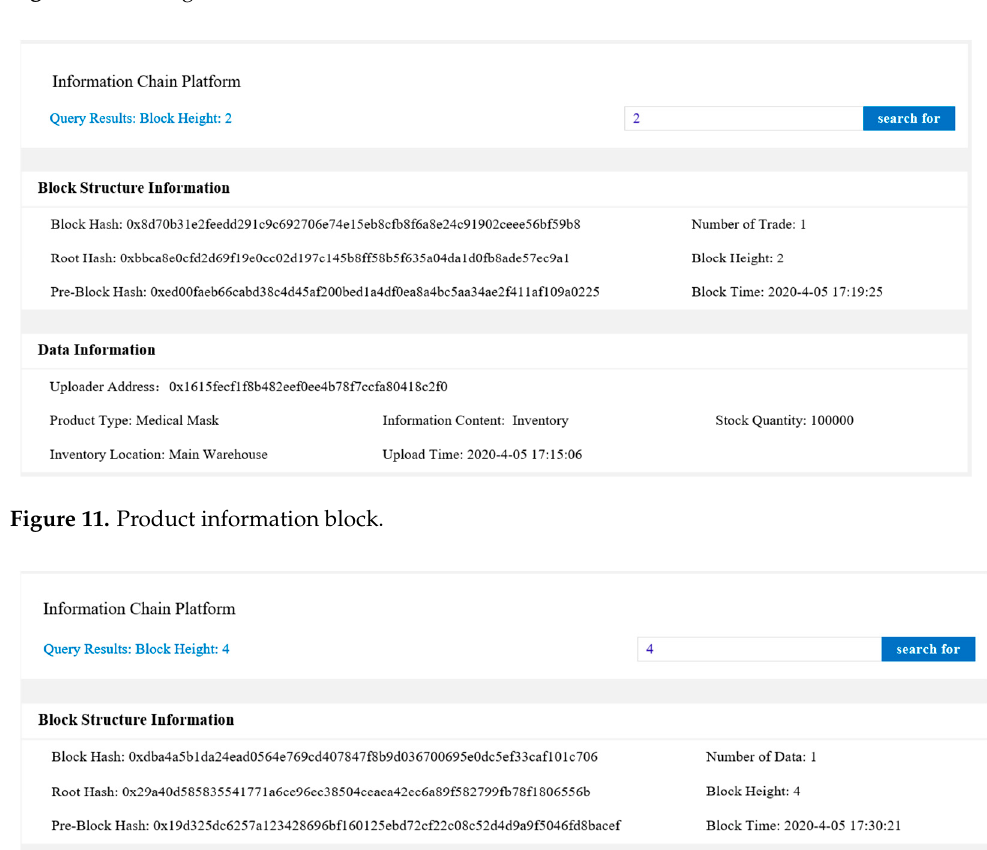
Figure 11. Product information block.